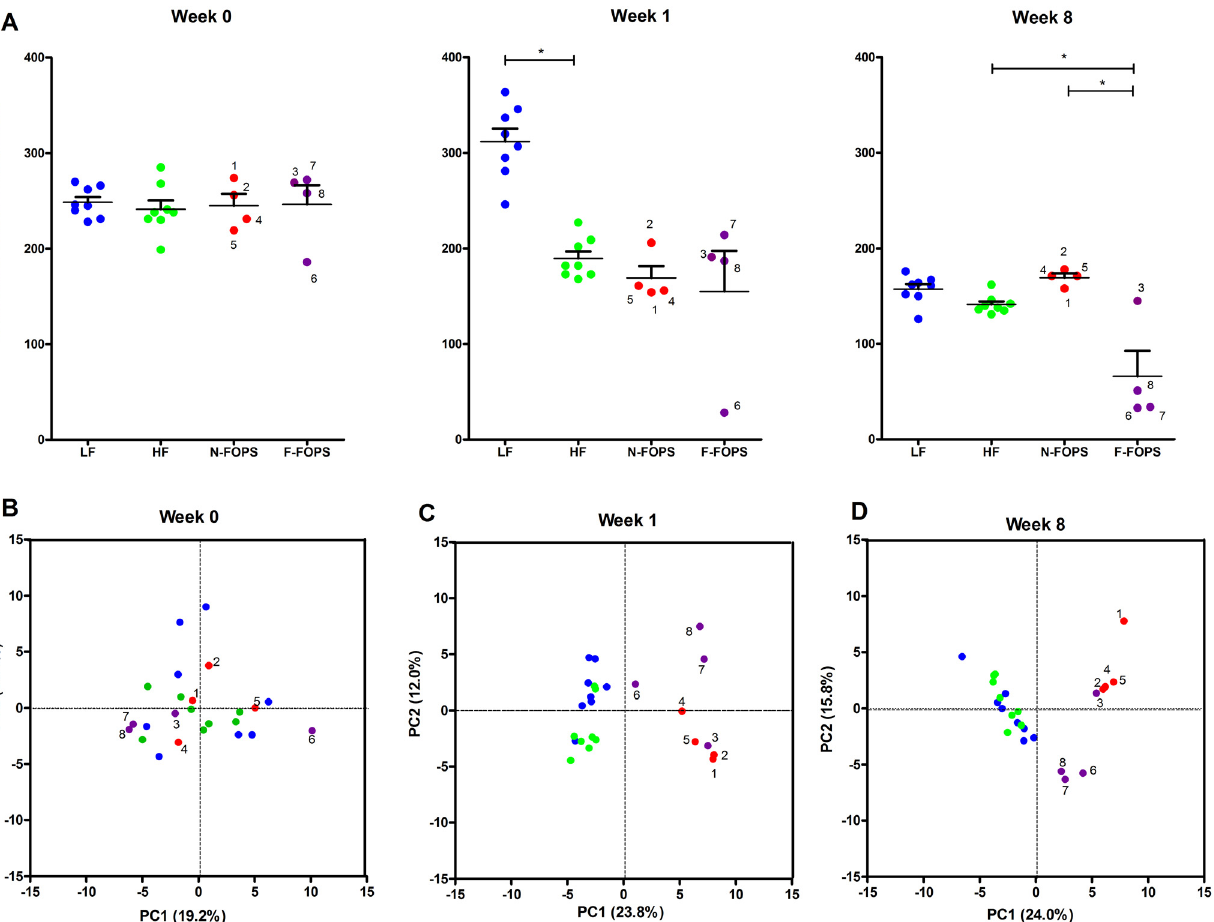
Fig 6. Diversity and principal components analysis of fecal bacterial communities in mice at 0, 1, and 8 weeks of feeding. α -Diversity (A) and principal components analysis of OTU abundances (B-D); data are presented in (A) as the mean ± SEM; n = 8 mice/group for HF and LF; n = 4 mice/group for N-FOPS and F-FOPS. (B-D) blue dots represent LF, green dots represent HF, red dots represent N-FOPS, purple dots represent F-FOPS; mouse numbers are shown for FOPS mice to track individual mice across figures; * indicates a significant difference (p < 0.05) between the indicated treatments using Bonferroni ’ s multiple comparison test with the following comparisons: LF vs. HF; HF vs. N-FOPS; HF vs. F-FOPS; N-FOPS vs.